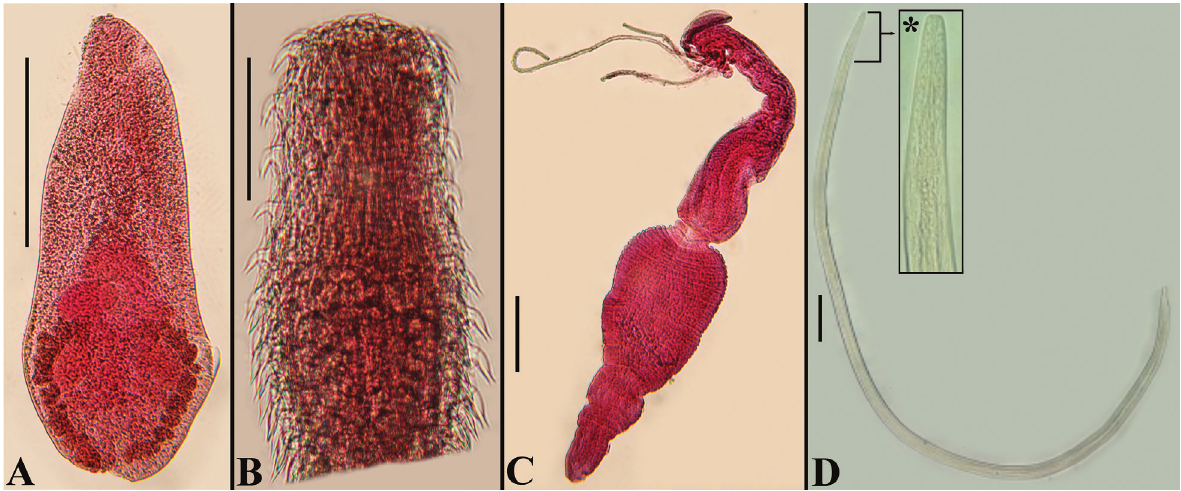
Figure 1. Helminth parasites of Emerita rathbunae . A Microphallus nicolli ; B Everted proboscis of an excysted specimen of Pro- filicollis sp.; C Cestode larva; D Proleptus sp., inset (*) = anterior end of worm. Scale bars: A = 500 µm; B = 200 µm; C = 100 µm; D = 100